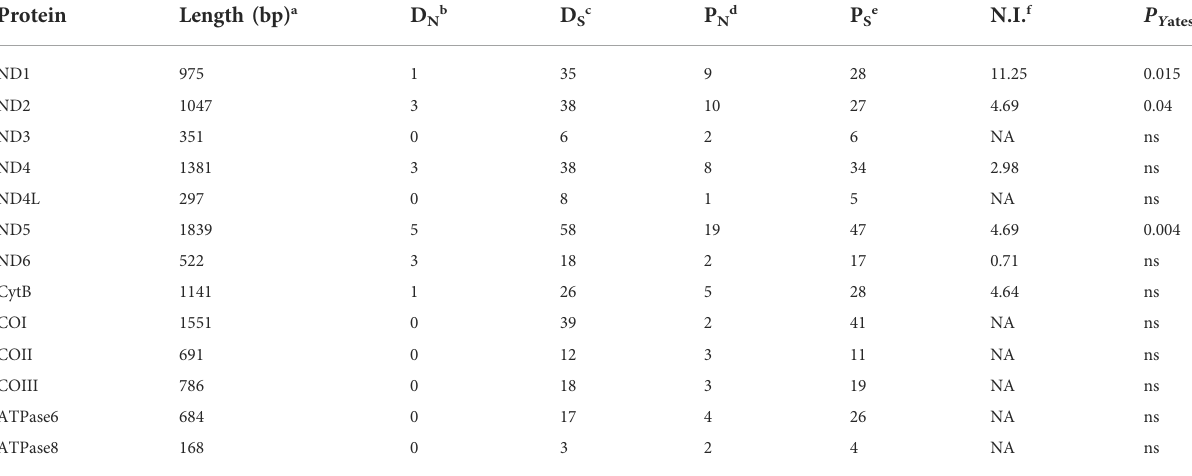
a length in base pairs of the related protein coding gene based on the Trans-North-Paci fi c (TNP) reference genome; b number of fi xed nonsynonymous changes between